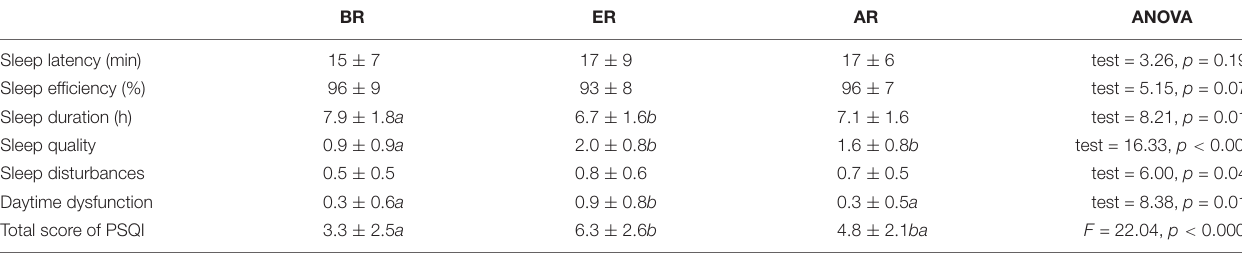
TABLE 1 | Subjective night-time sleep quality recorded before, during and after Ramadan.